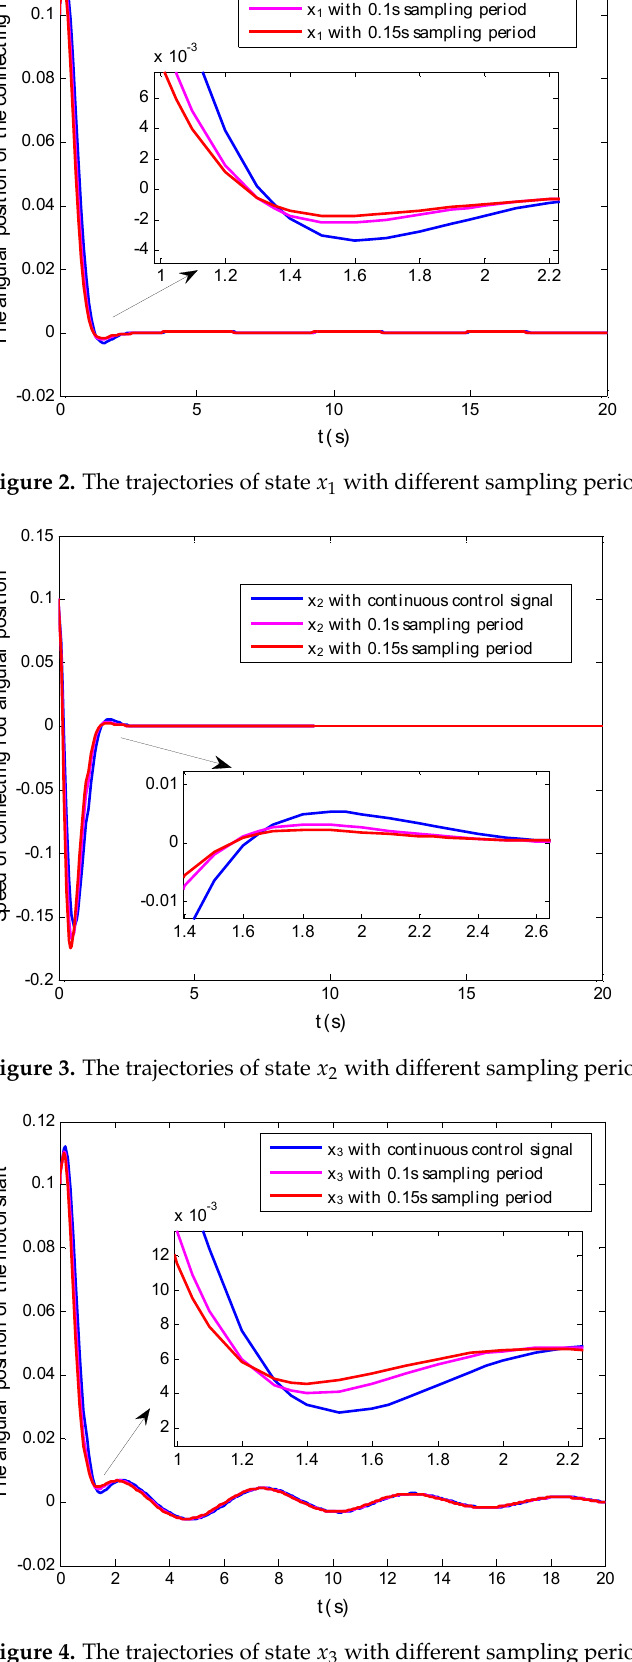
Figure 4. The trajectories of state x 3 with different sampling periods.